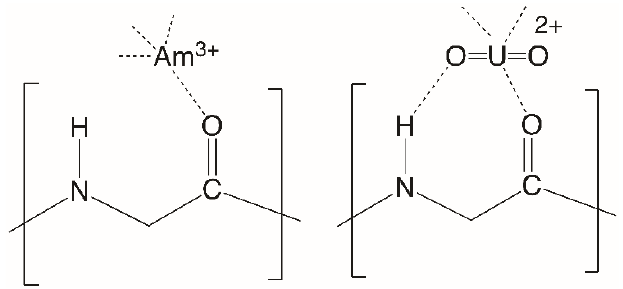
Figure 3. Schematic illustration of the interactions between Am(III) or U(VI) cations and the PN6 amide moiety.